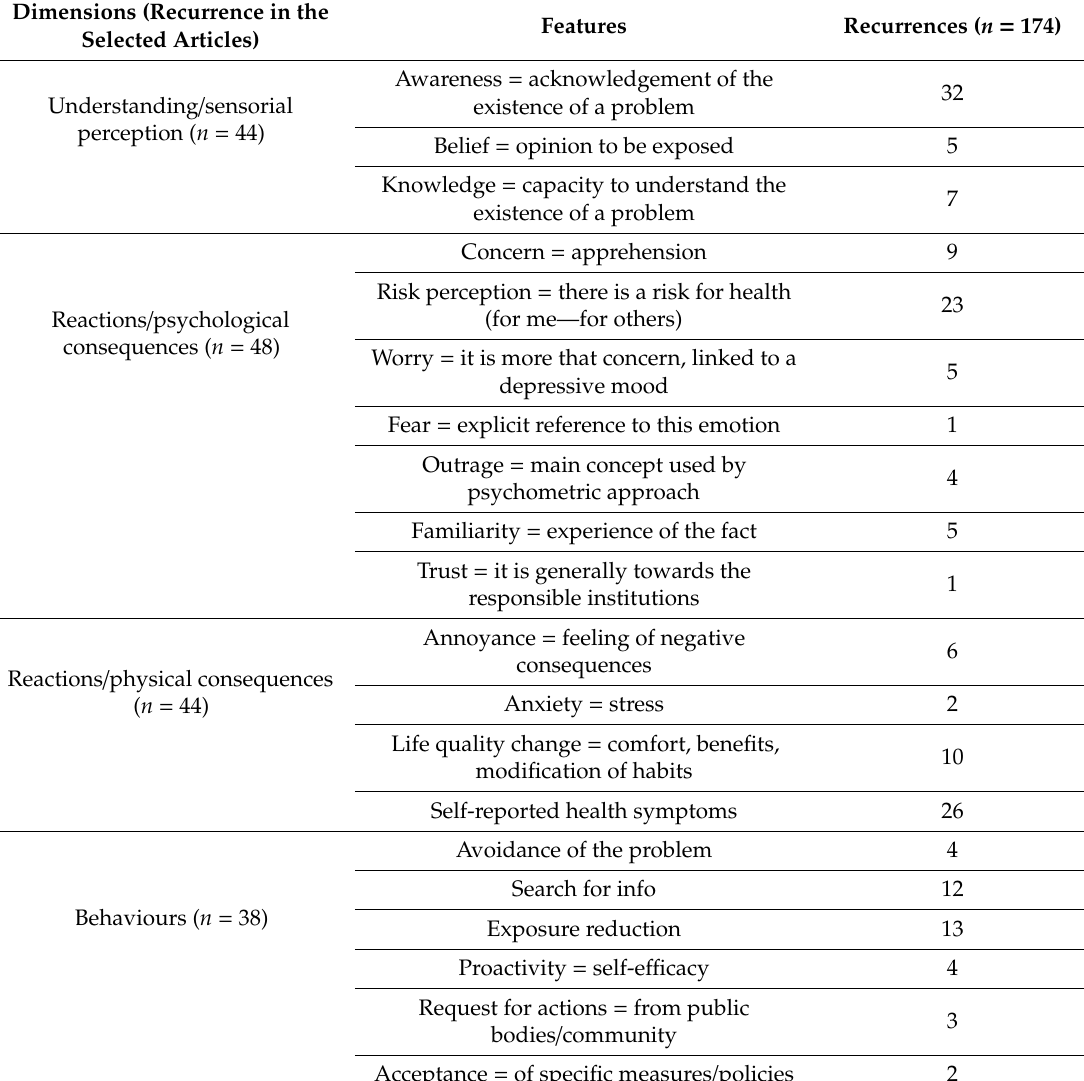
Table 2. Recurrence of dimensions and features related to risk perception in the selected articles. Dimensions (Recurrence in the Selected